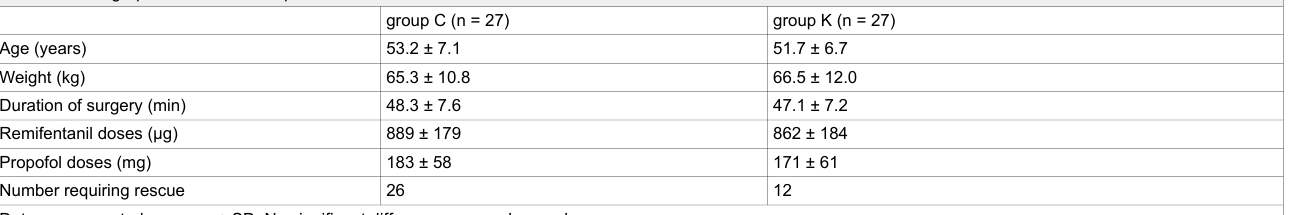
Table 1: Demographic data and intraoperative outcomes.